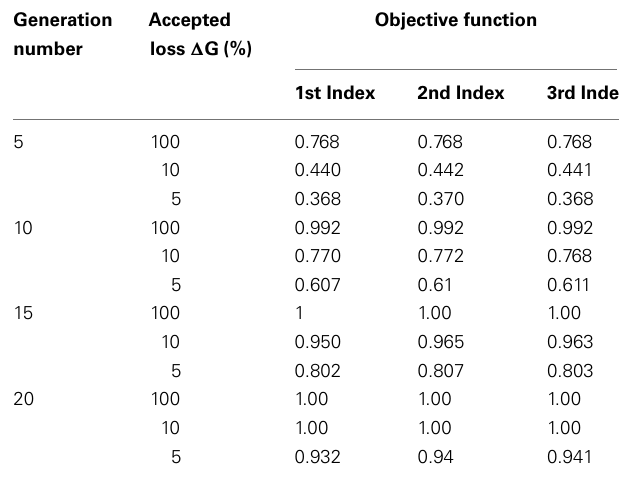
Table 4 | Results obtained with different values of coefficients in the stochastic model: coefficients from the optimization of the stochastic model and coefficients from the optimization of the deterministic model.